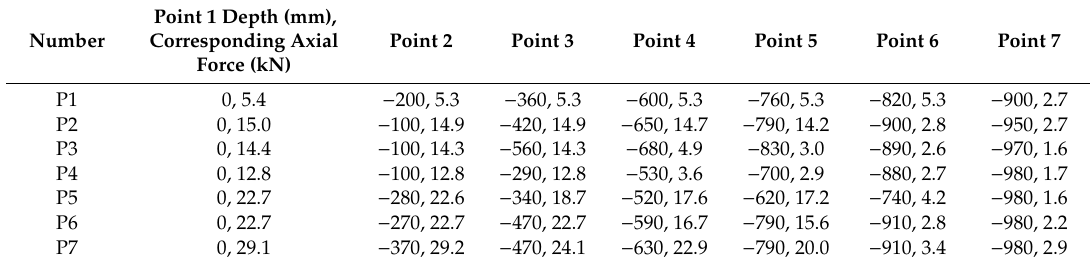
Table 2. The distribution of axial force along the pile